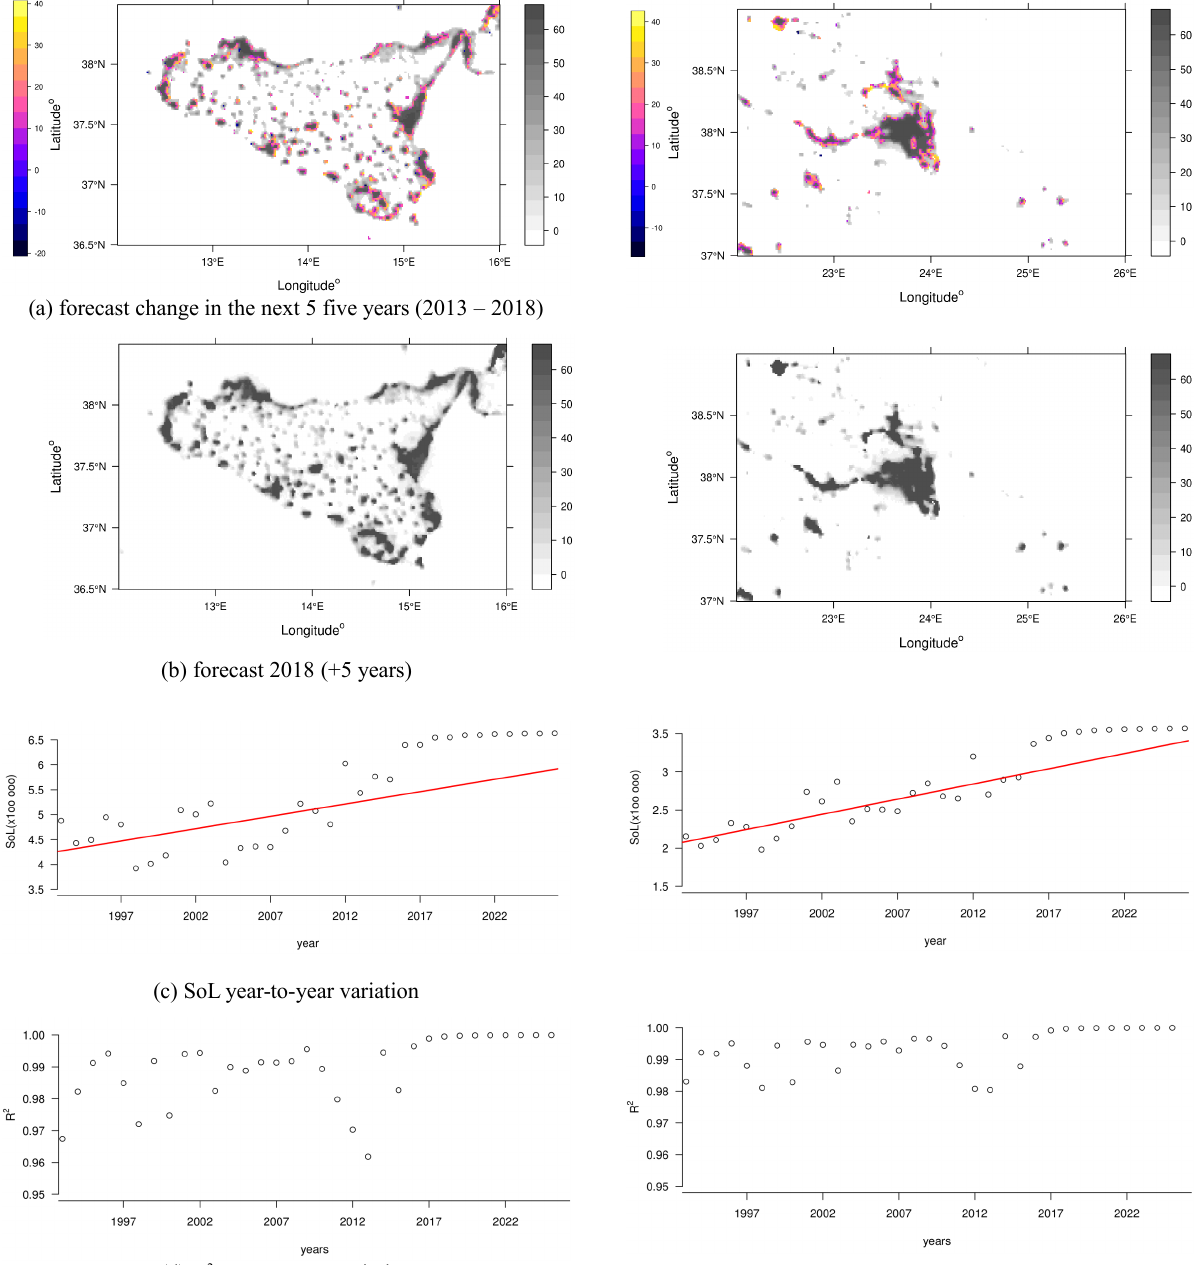
Figure 3. Forecast results for Sicily (left) and Athens